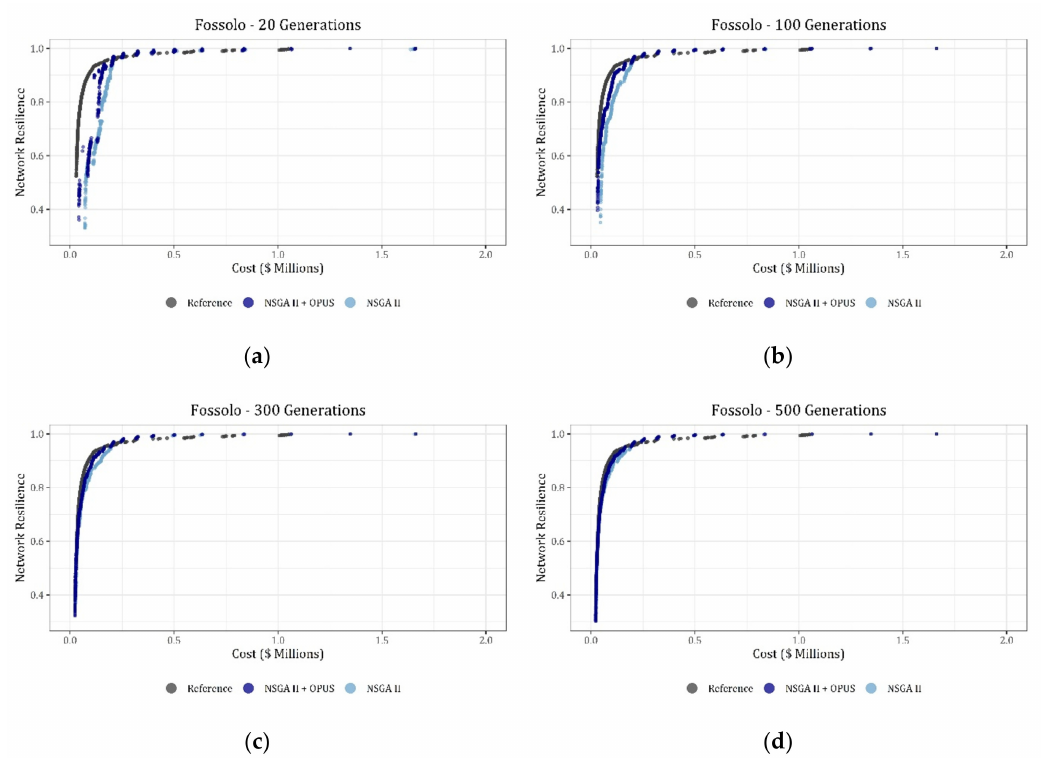
Figure 3. Evolution of the PFs for the NSGA-II algorithm (light blue) and the retrofitted NSGA-II with OPUS (dark blue) in comparison to the best-known PF (black) for Fossolo. ( a ) 20 generations; ( b ) 100 generations; ( c ) 300 generations and ( d ) 500 generations.